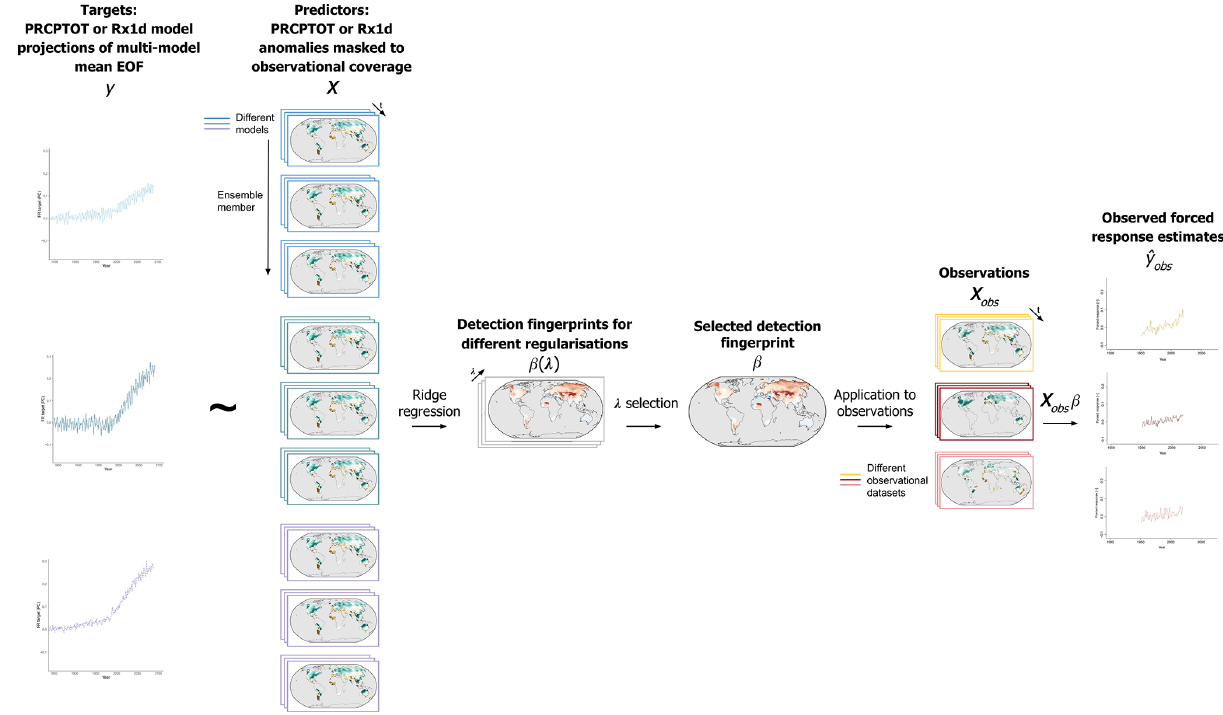
Figure 1. Flowchart of ridge regression model training procedure as well as application of detection model to